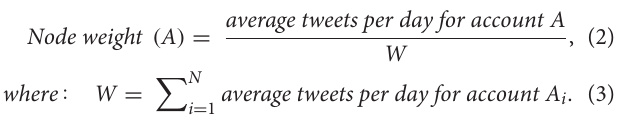
Figure 7 visualizes an ego network with 30 nodes and 142 edges, (a) without assigning weights to the nodes and edges, and (b) by